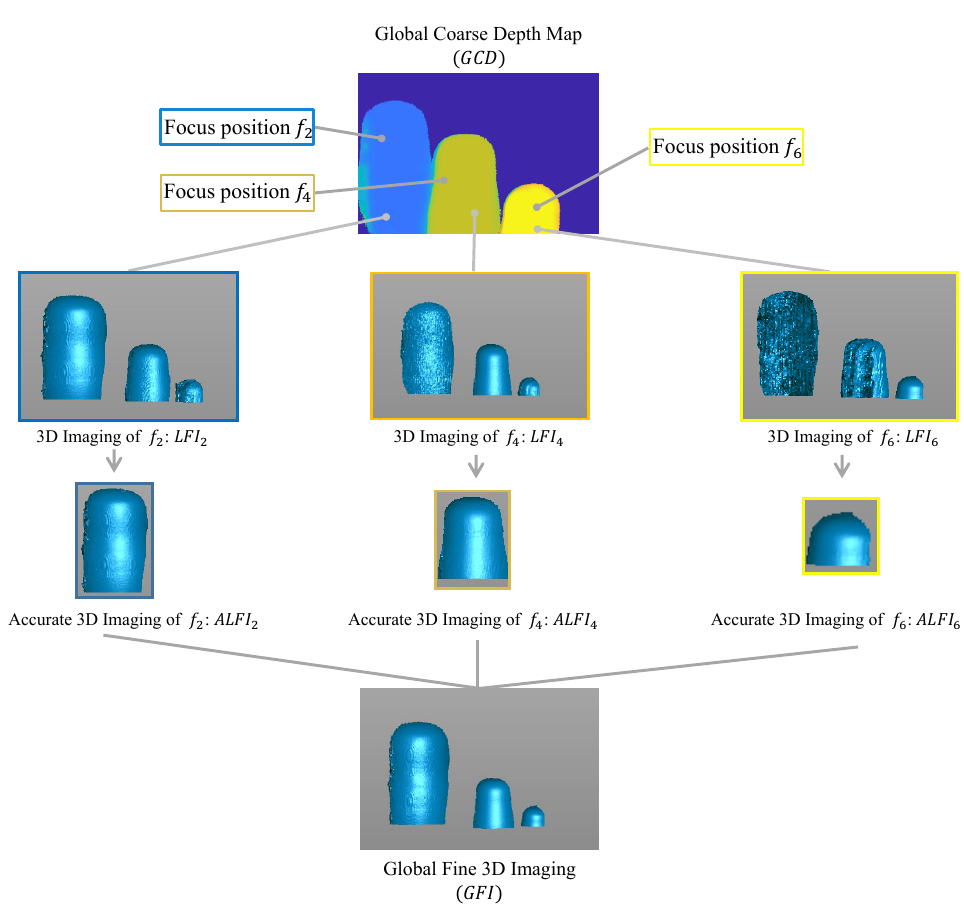
Figure 3. The guided fusion model. The global coarse depth map contains the corresponding focus position of each object. Therefore, we can extract the accurate region of each local fine 3D measurements under the guidance of the global coarse depth map to fuse into the global fine 3D